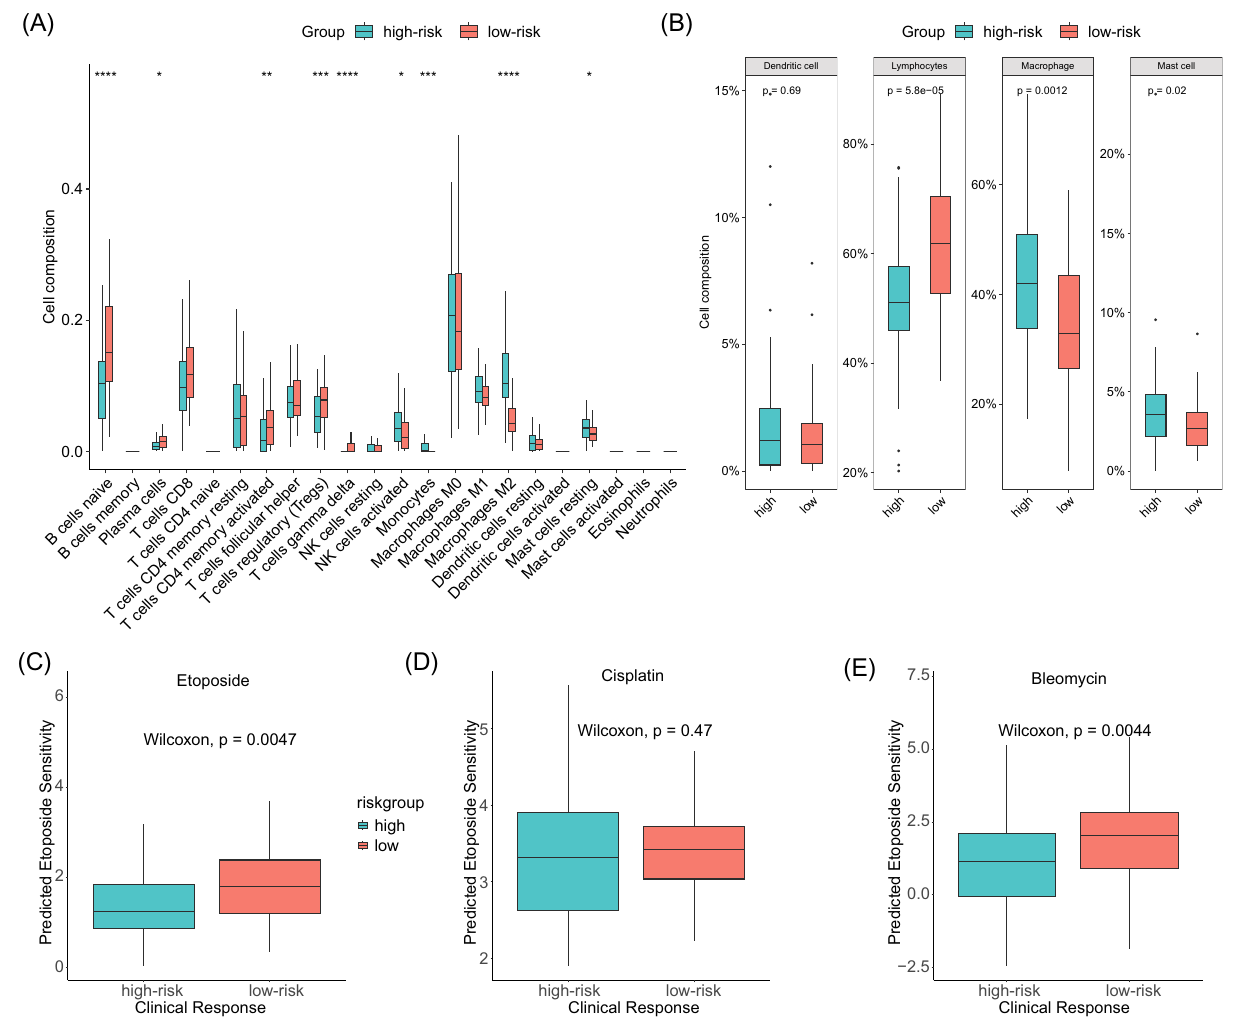
Figure 6. Immunoinfiltration and chemotherapy sensitivity analysis in the TCGA–TGCT cohort. ( A ) Comparison of the infiltration of 22 types of immune cells in high-risk and low-risk groups. ( B ) Comparison of the infiltration of 4 categories of immune cells in high-risk and low-risk groups. ( C – E ) Comparison of chemosensitivity to etoposide, cisplatin, and bleomycin in high-risk and low-risk groups,